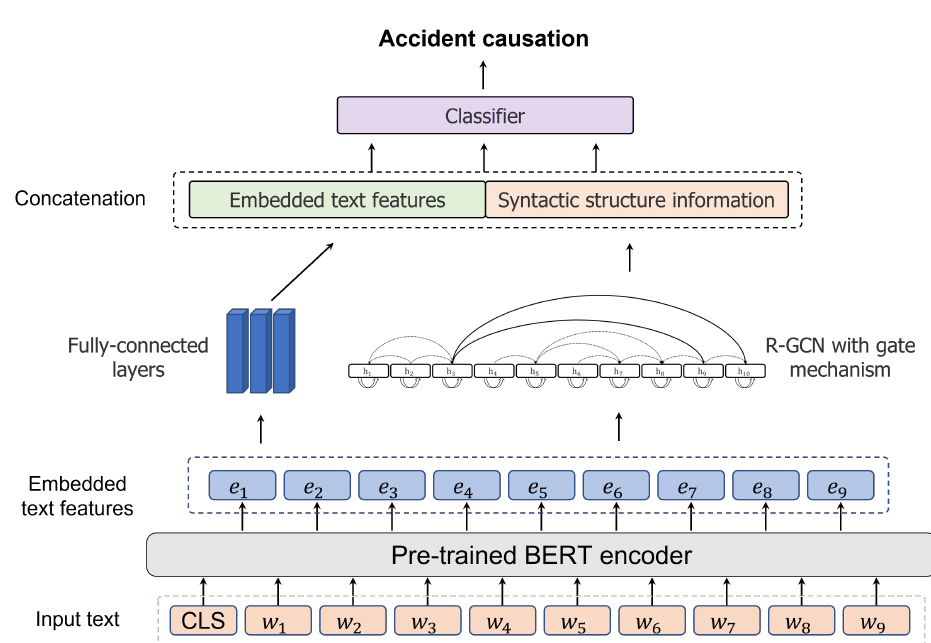
Figure 4. Structure of pre-trained BERT combined with